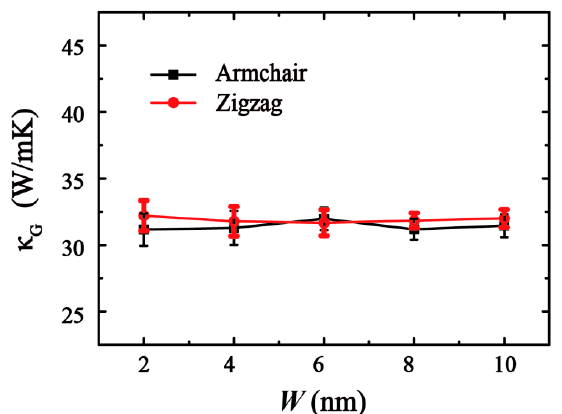
Figure 4. Curve of thermal conductivity with different sample width. The width varies in [0, 10] nm.